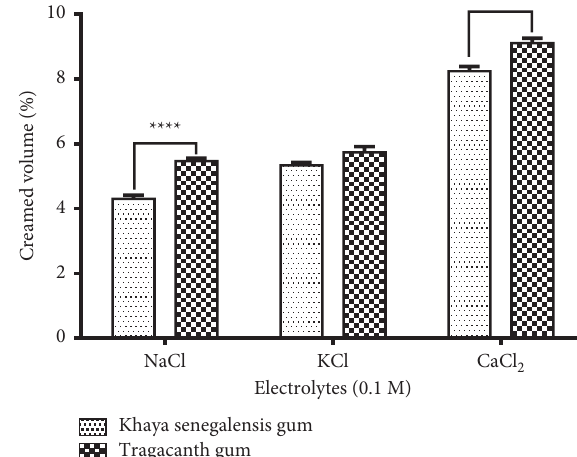
Figure 10: The effect of electrolytes on castor oil emulsion using Khaya senegalensis gum as an emulsifier. Values are means ± SEM ( n � 3). ∗∗∗∗ P < 0 . 0001 , ∗∗ P < 0 . 01 compared with emulsions with tragacanth gum (two-way ANOVA followed by Dunnett’s multiple comparisons